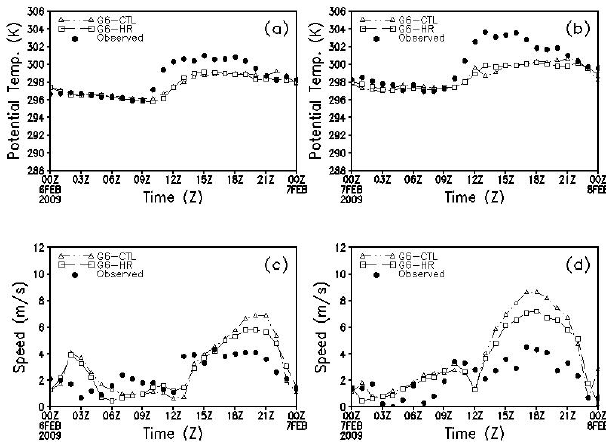
Figure 11. Time cross-section data of (a, b) θ (K), and (c, d) wind speed (ms − 1 ) observed (closed circle) and simulated by G5 of the CTL (open triangle) and HR (open square) runs from 00:00UTC 6 February to 00:00UTC 8 February 2009 at JPA surface weather- observation station.